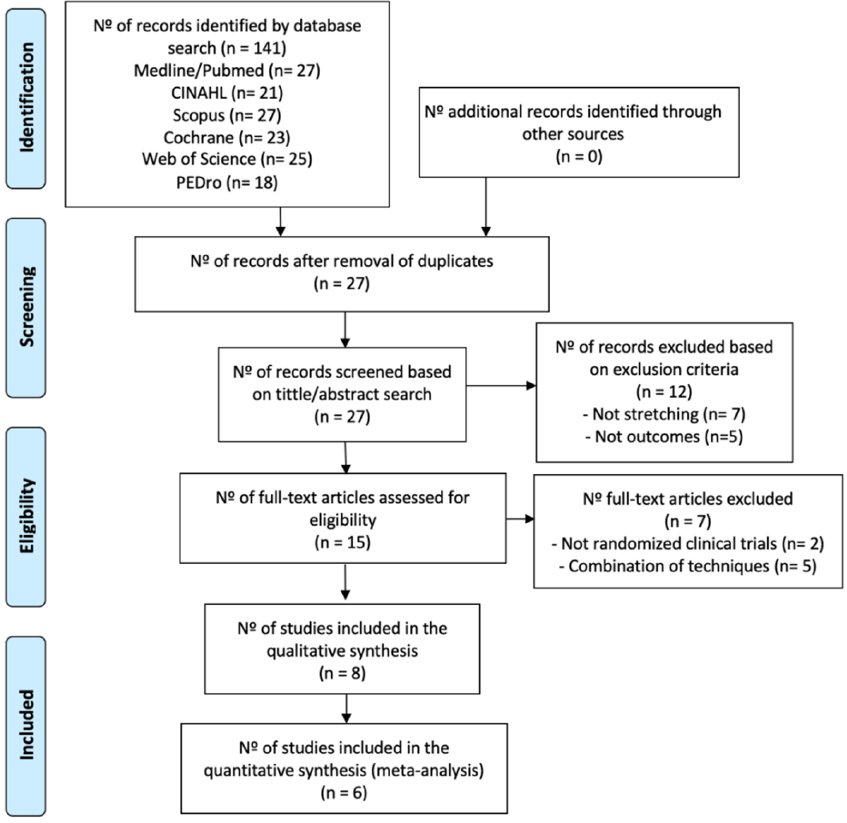
Figure 1. Information flowchart of the different phases of the systematic review.